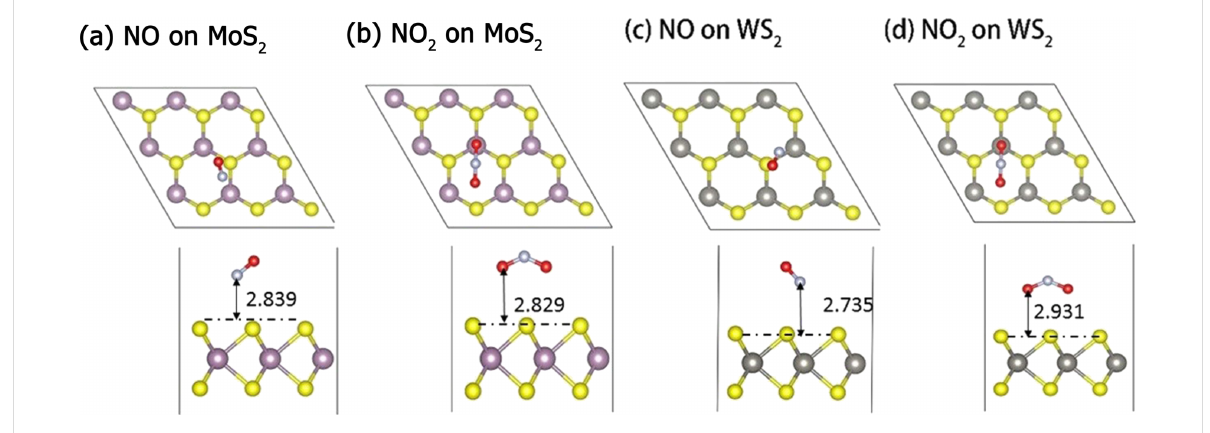
Figure 1: Top and side views of the most favorable NO and NO 2 adsorption configurations on monolayers of MoS 2 and WS 2 . The yellow, purple, grey, white and red balls represent S, Mo, W, N, and O atoms, respectively.